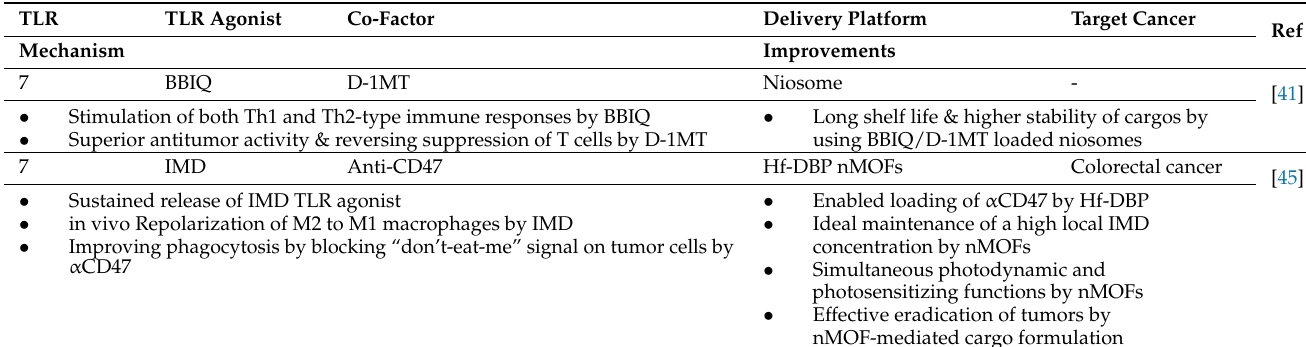
Table 4. Combinative delivery of TLR agonists with various